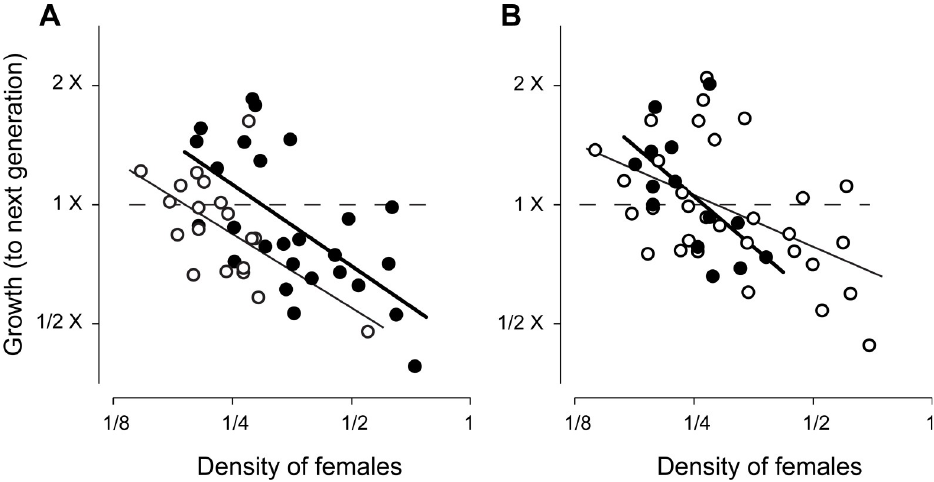
Fig 6. Inverse relations between growth rates and densities of female P . downsi , expressed as Log 2 -transformed daily catch rates. A: Growth at lowland site (filled circles) versus highland site (open circles), seasons combined; B: growth during bird breeding season (filled circles) versus non-breeding season (open circles), locations combined. Solid lines are least-squares regression lines fit to data in each subgroup separately. Horizontal dashed lines indicate population replacement, and intersections with regression lines indicate estimated carrying capacities, which were greater at the lowland site, but independent of bird breeding season.